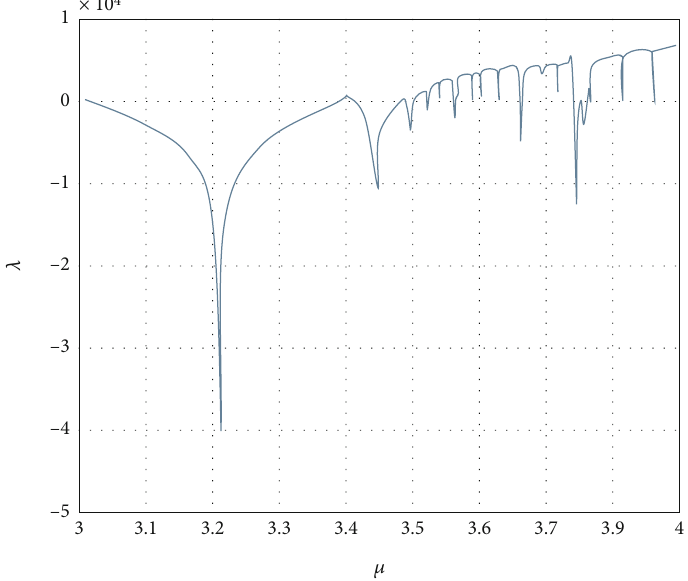
Figure 2: The Lyapunov exponent plot of logistic mapping.